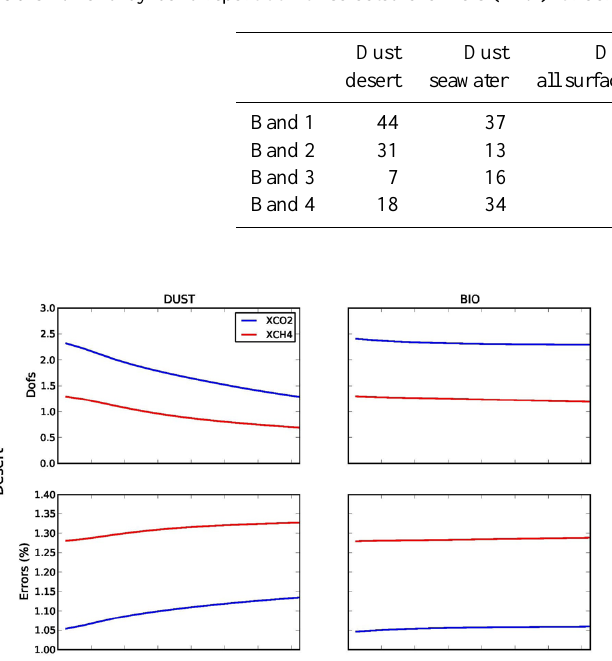
Table 4. Band-by-band repartition of selected channels (in %) for aerosol parameter retrieval.